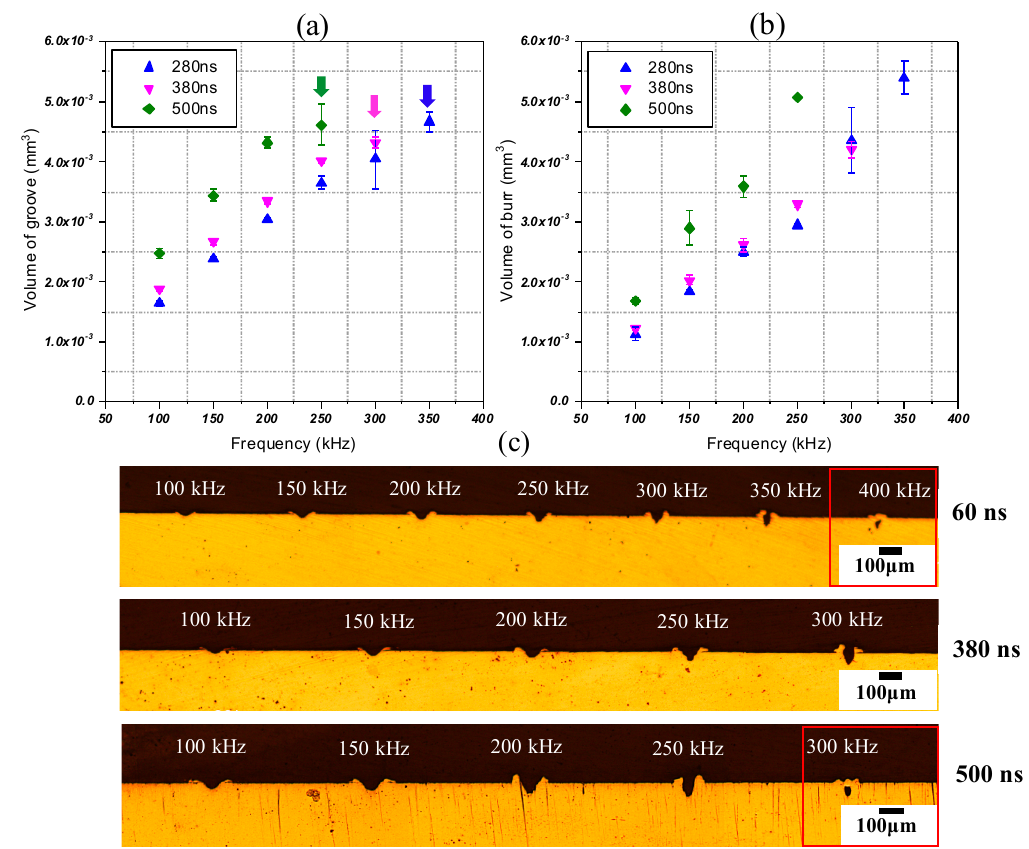
Figure 7. ( a ) Volume of groove; ( b ) volume of the burr as a function of PRF at a constant ED L of 0.09 J / mm; and ( c ) cross-sectional view for the influence of change in PRFs at 280 ns, 380 ns, and 500 ns.